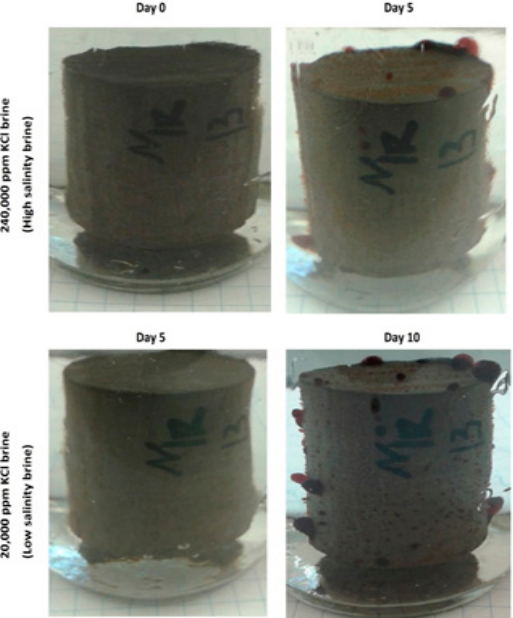
Figure 5. A preserved one-inch diameter Bakken shale core sample submersed in high-salinity brine (240,000 ppm KCl) ( top ) and low-salinity brine (20,000 ppm KCl) ( bottom ) showing oil expulsion vs. imbibition period. At imbibition Day 5 ( top ), the core was removed from a high-salinity brine beaker and produced/expelled oil was wiped and immersed in low- salinity brine from Day 5 until Day 10 ( bottom ). This shows that more oil is expelled due to osmosis during a low-salinity brine imbibition